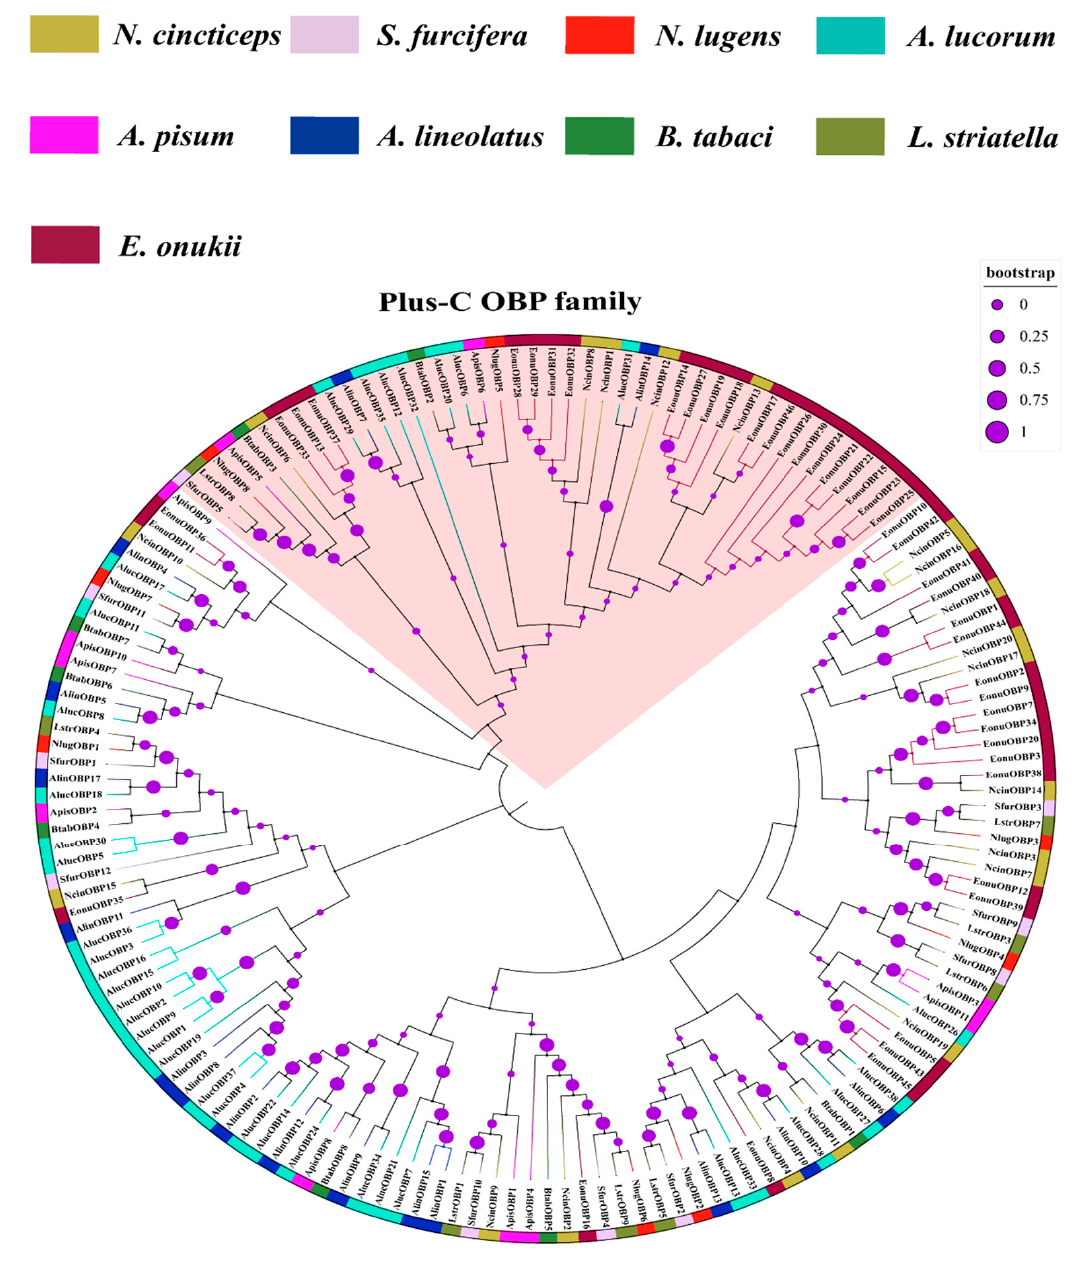
Figure 3. Neighbor-joining tree of 161 OBPs proteins from nine species of Hemiptera. Bootstrap values are shown. The Hemiptera species used to construct the tree are E. onukii , N. lugens , S. furcifera , L. striatella , B. tabaci , A. lucorum , A. lineolatus , A. pisum and N. cincticeps . The OBP phylogenetic trees were constructed by MEGA 6.0 software with the neighbor-joining method using the Poisson correction distance and 1000 bootstrap replications. The final phylogenetic trees were optimized and visualized by an online tool, iTOL (https://itol.embl.de/ (accessed on 12 March 2021)). The meaning of the pink highlight in the phylogenic tree was the “Plus-C” OBP